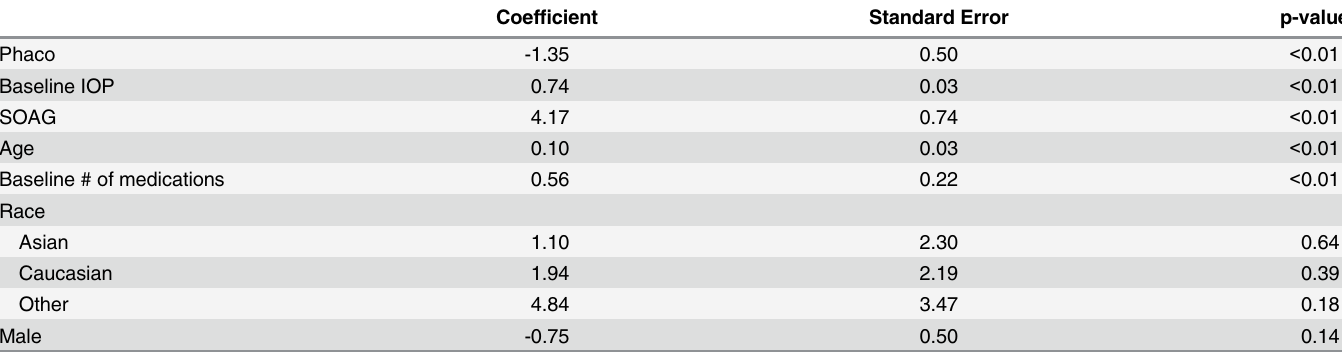
Table 3. Univariate linear regression of patient parameters of study. A p-value of < 0.05 is considered statistically significant. Coef fi cient Standard Error